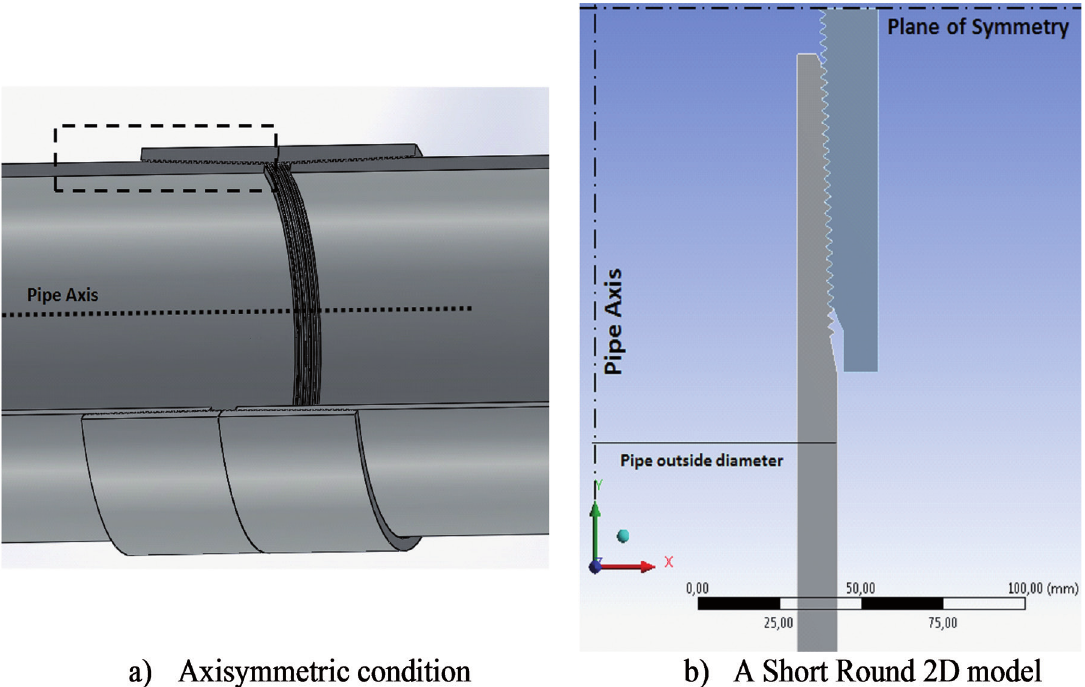
Figure 1: CAD models of the treaded connections (a) API Casing connection and symmetry related to the coupling middle and the pipe axis; (b) 2D axisymmetric model.